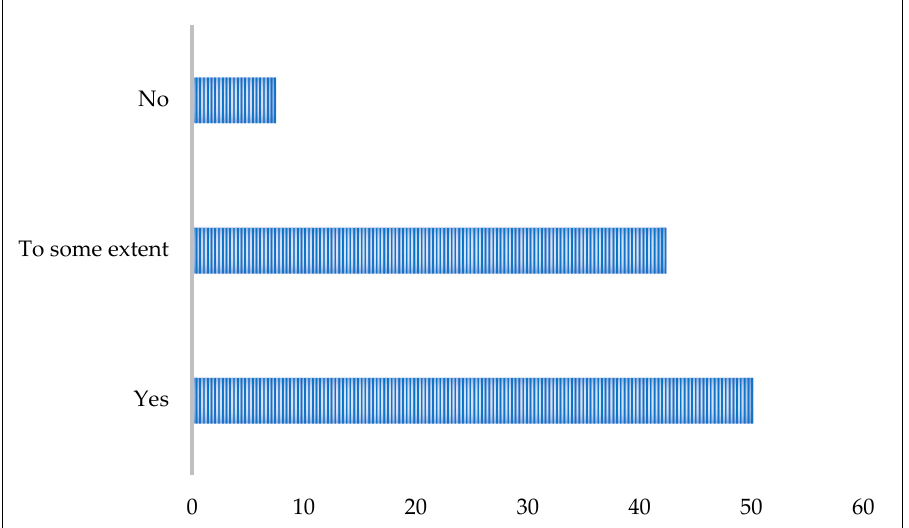
Figure 13. The ability of residential unit to facilitate social distancing.